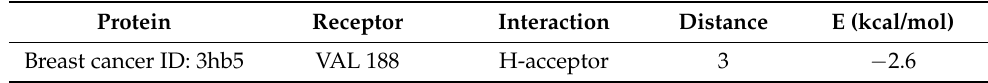
Table 6. Binding energy of the interaction of